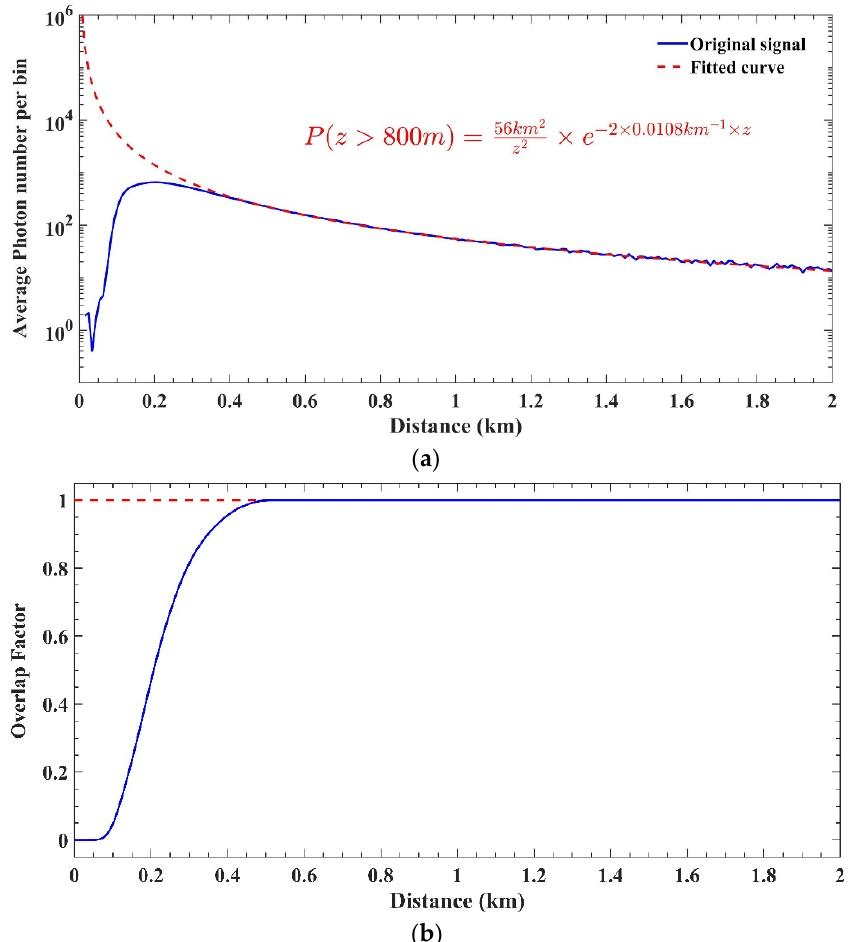
Figure 7. ( a ) The original signal and its fitting results for overlap factor measurement. Red dashed curve is the fitted signal evolution from the measured far-field signal ( b ) The overlap factor retrieved by comparing the measured and fitted signal.